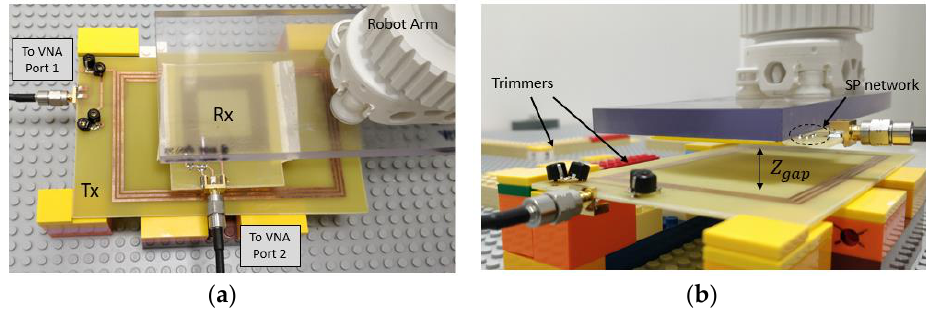
Figure 14. Measurement setup for the new prototypes are shown: ( a ) top view: receiver at horizonal position with VNA connections; ( b ) side view: separation (𝑍 𝑔𝑎𝑝 = 10 mm) , trimmers, and SP compensation network.